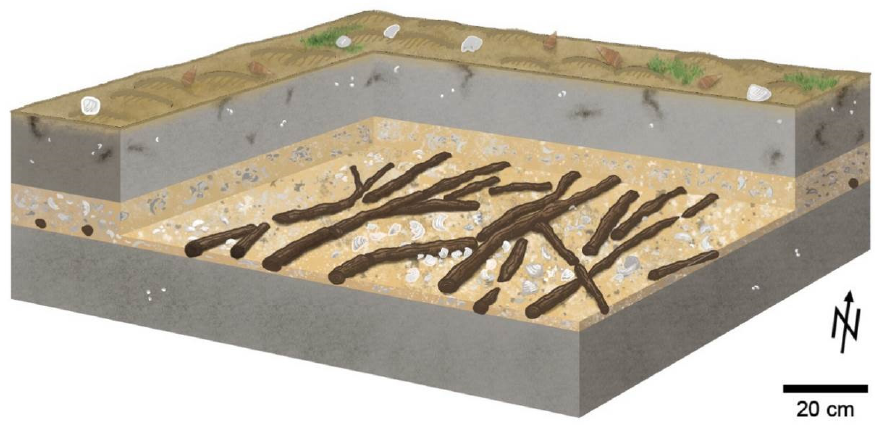
Figure 3. Block diagram showing the subfossil woody axes in situ, aligned NNE–SSW, and embedded at the base of the tsunamigenic layer (depicted in beige) in between gray lagoonal layers. Towards the top of the block are some redoximorphic features, living Cerithidea cingulata gastropods, a few bivalve shells, and small mats of seagrass on the surface.